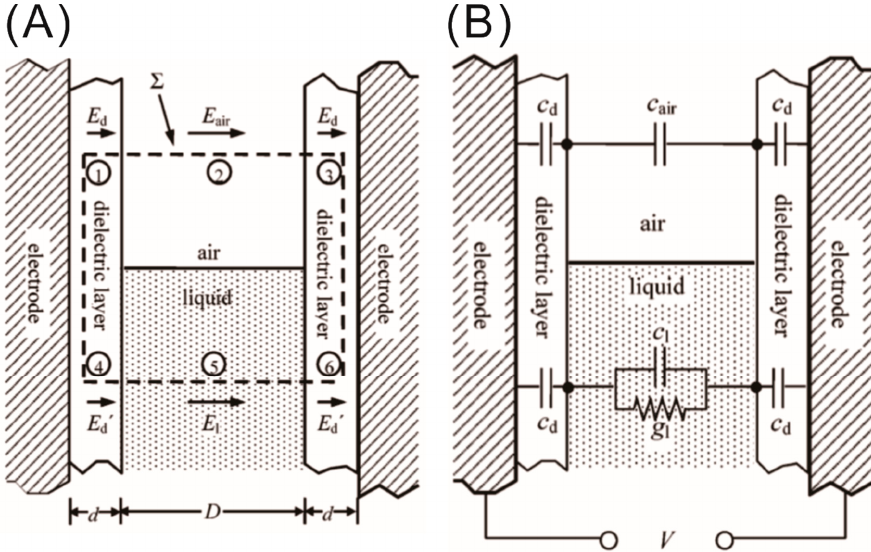
Figure 2. ( A ) Schematic representation of the closed surface integral Σ and corresponding area for calculation of net vertical force of electrical origin on the liquid between insulator-coated electrodes. The choice of closed surface integral is reduced to a simple summation of six discrete areas denoted by 2 for the contribution of air, 5 for the contribution from liquid, and 1 and 3, and 4 and 6 for the contribution from the dielectrics above and below the air–liquid interface, respectively. ( B ) Schematic representation of the equivalent resistor / capacitor (RC) circuit model for determination of the electric field in di ff erent regions. Images are reproduced from Reference [30] with the permission of the American Chemical